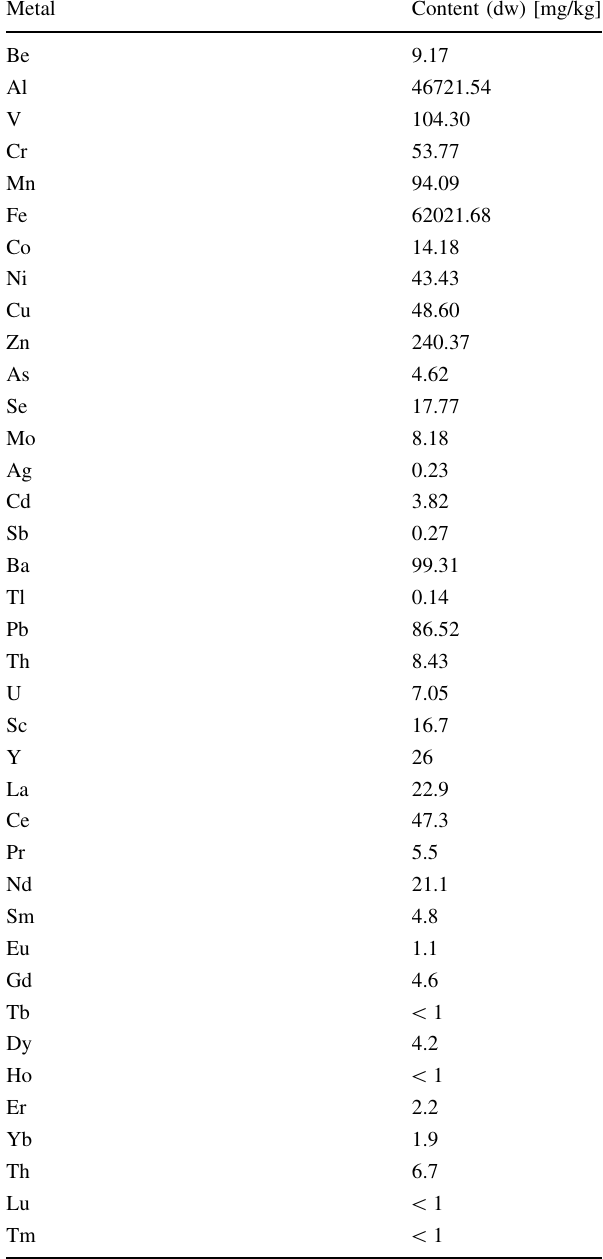
Table 1 Elemental composition of fly ash